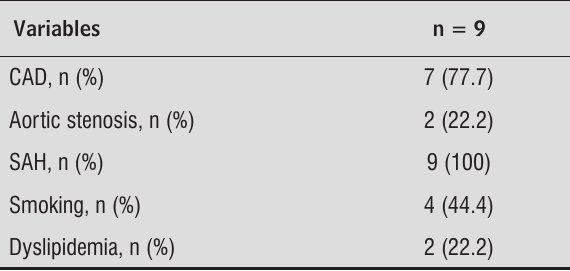
Table 1 - Baseline characteristics of the study population Variables